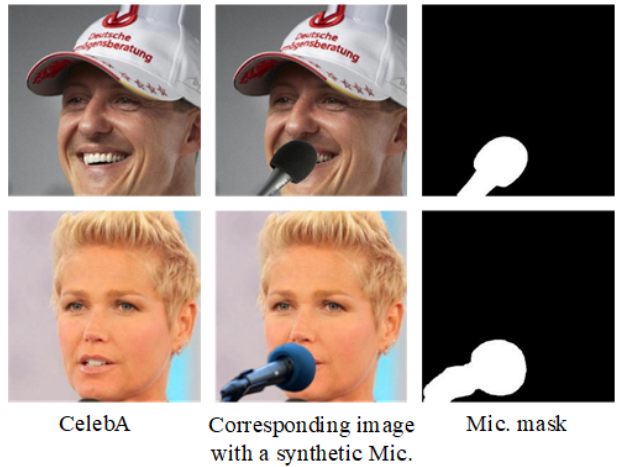
Figure 4. Example images with their masks from the synthetic